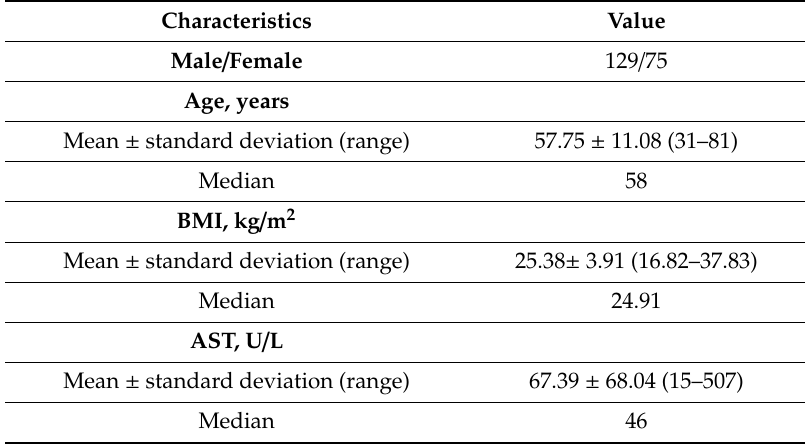
Table 1. Demographic data of patients enrolled in the